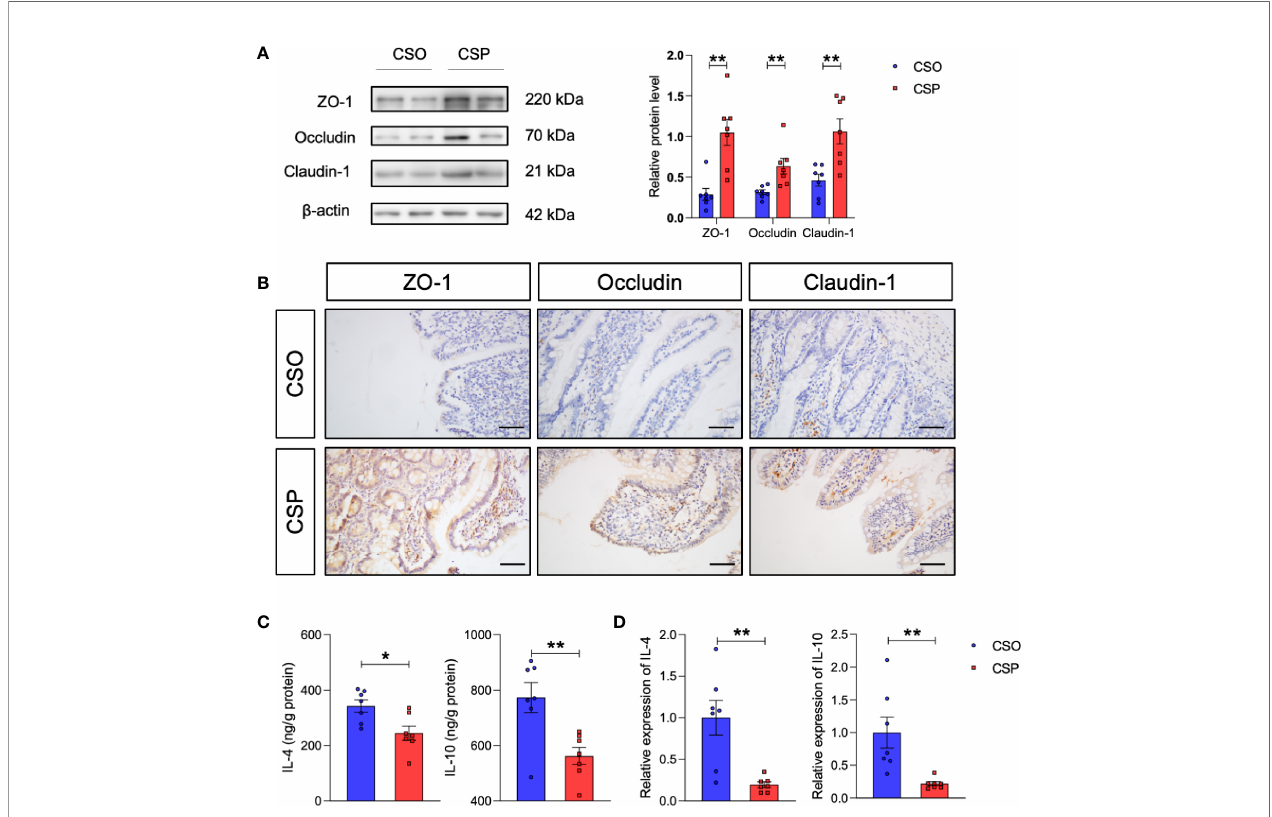
FIGURE 7 | Probiotic intervention reverses the changes in tight junction proteins and Th2 cytokines induced by CS in food allergy. (A) Western blot analysis of the tight junction proteins ZO-1, occludin, and claudin-1 in the ileum. b -actin was used as the internal control (left panel). Grayscale statistics of tight junction proteins relative to b -actin (Right panel). n = 7. (B) Representative images of immunohistochemistry staining for ZO-1, occludin, and claudin-1 proteins. Scale bar = 50 m m. (C, D) IL-4 and IL-10 levels measured by ELISA (C) and q-RT-PCR (D) . n = 7. Data are expressed as means ± SEM. Statistical signi fi cance was determined by two-sided Student ’ s t-test or one way ANOVA, * P < 0.05, ** P < 0.01. CSO, the cesarean section offspring; CSP, cesarean section with probiotic